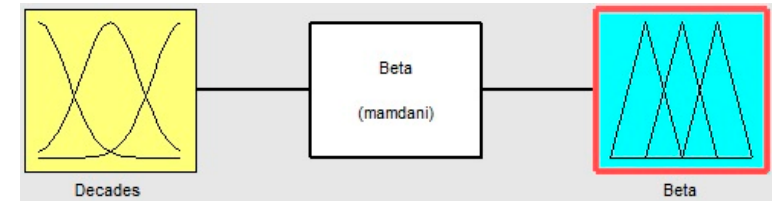
Figure 9. FICA β .